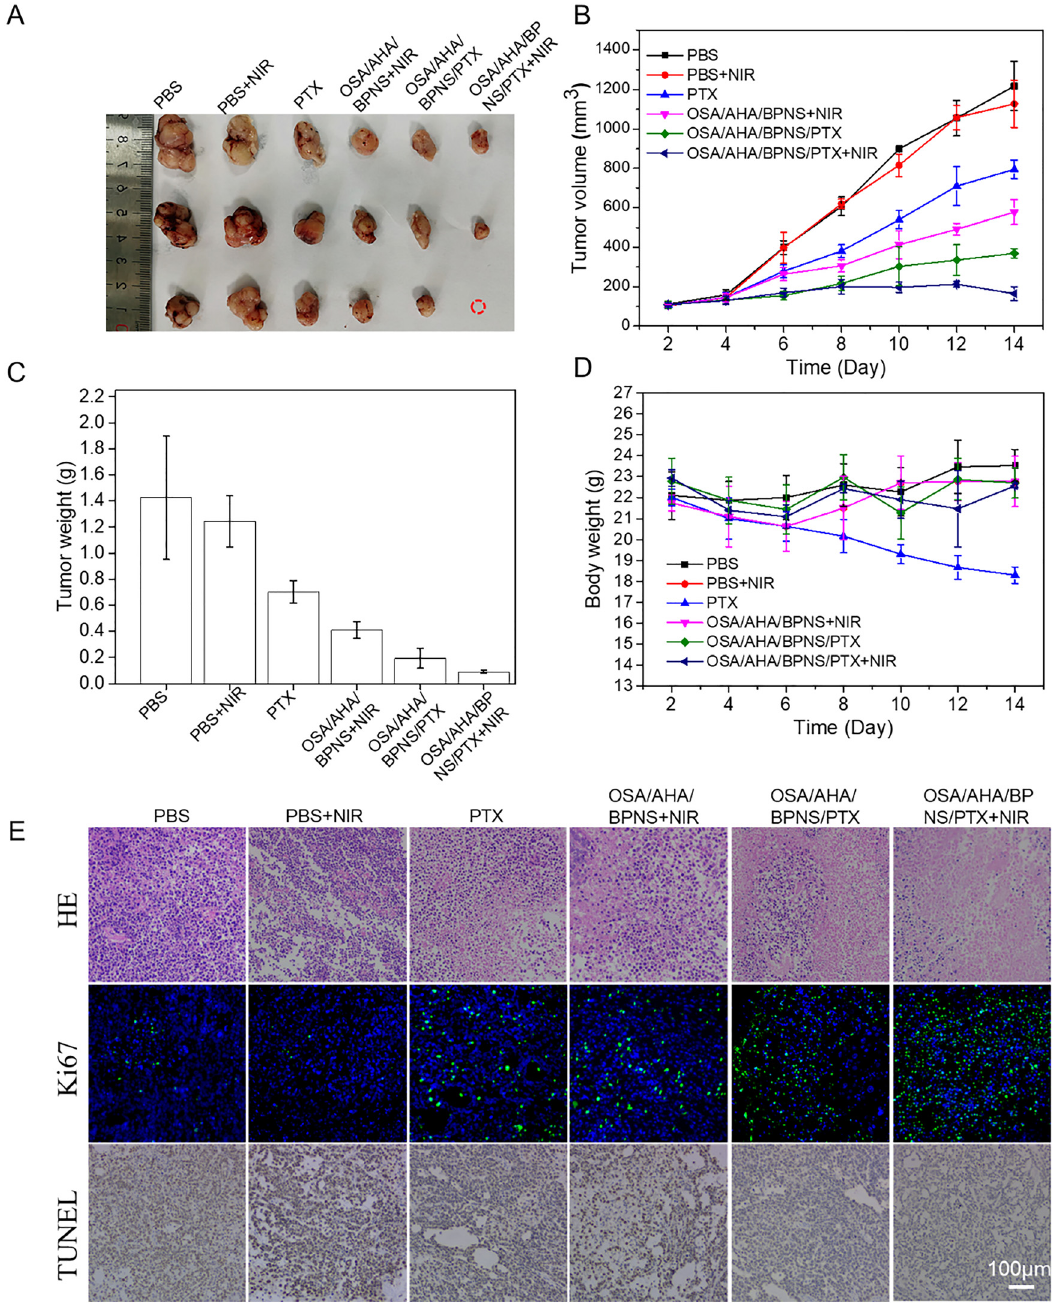
Figure 5: In vivo therapy evaluation. Tumor-bearing nude mice were divided to six groups randomly with treatment of PBS, PBS + NIR, PTX, OSA/AHA/BPNS + NIR, OSA/AHA/BPNS/PTX, and OSA/AHA/BPNS/PTX + NIR. (A) Images of tumor tissues in each group collected on day 14. (B) Tumor growth curve in terms of volume within 14 days under different treatments. (C) Average tumor weight in each group after 14 days treatment. (D) Body weight changes of BALB/c mice bearing SGC7901 tumors recorded every other day after different treatment. (E) H&E, TUNEL, and immunohistochemical Ki67 staining of tumor sections in each